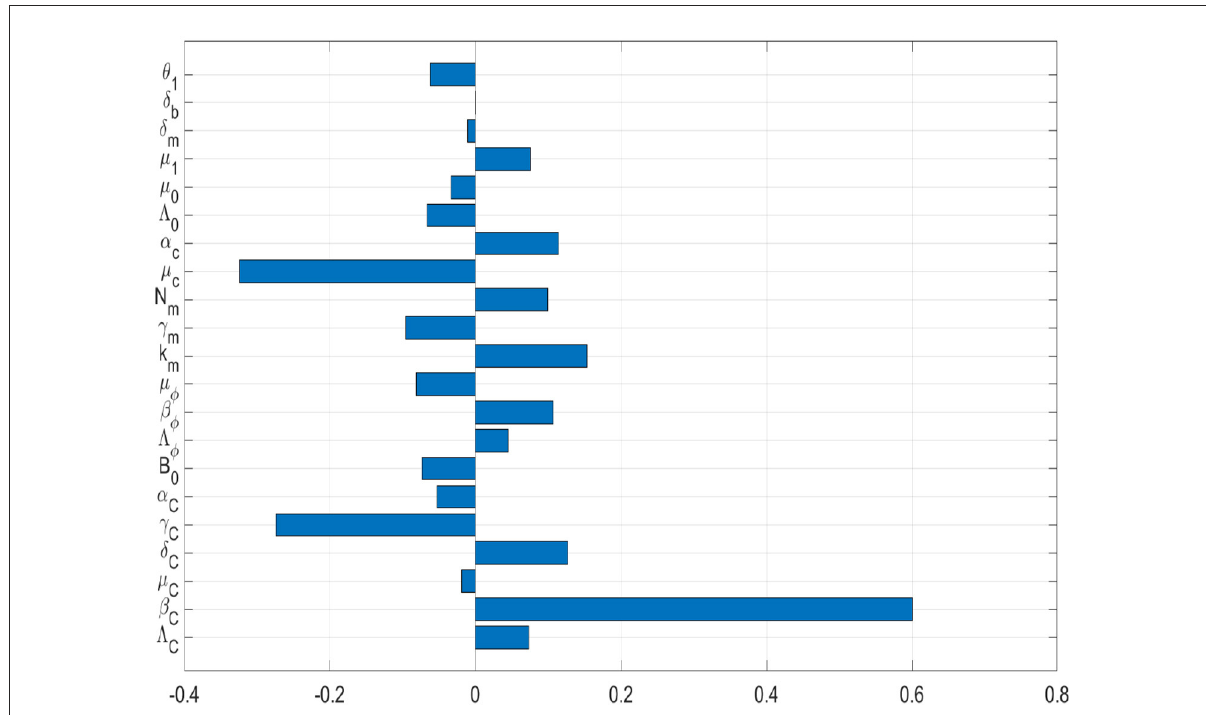
FIGURE7 Tornado plot of partial rank correlation coefficients (PRCCs) of the model parameters that influence the PTB transmission metric B ∗ C .